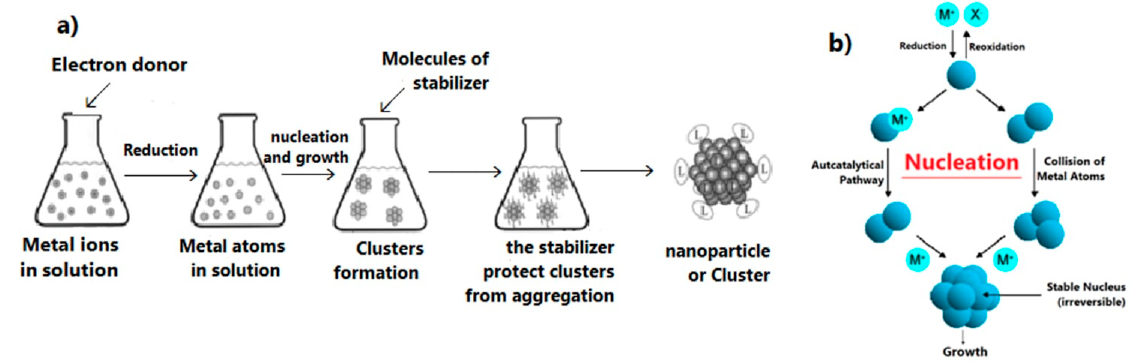
Figure 12. Simplified scheme shows ( a ) the stages of the formation of nanoparticles that are stable and protected from aggregation, ( b ) formation of small clusters and their growth (nucleation and growth).